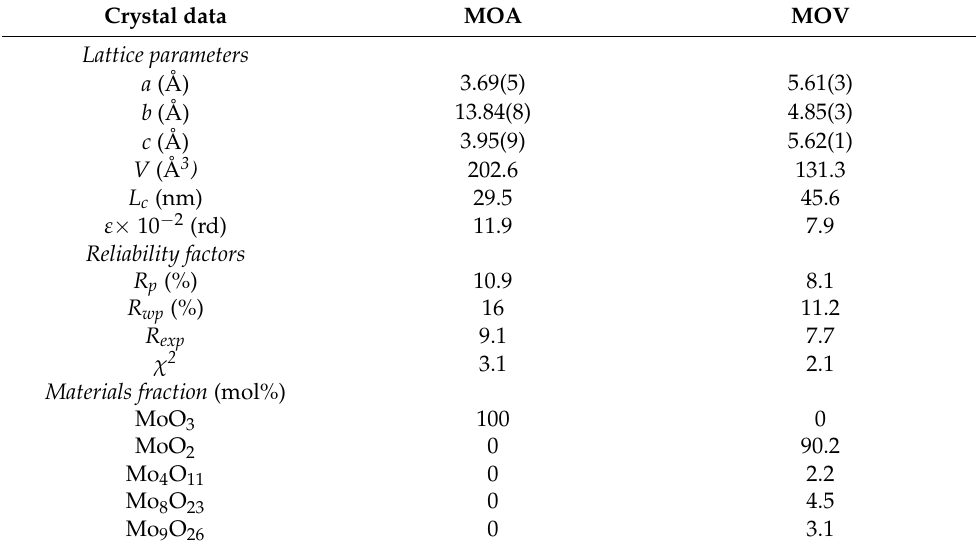
Table 1. Results of the Rietveld refinements for the MOA and MOV samples. Crystal